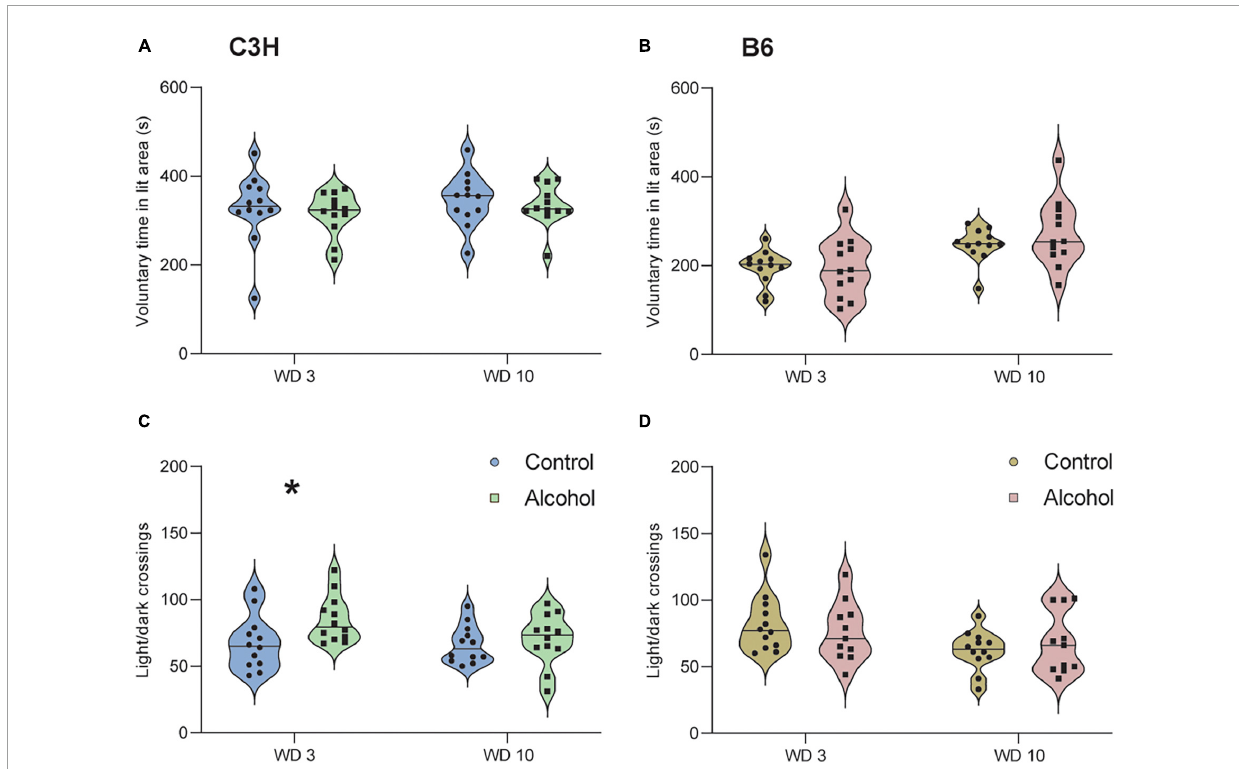
FIGURE5 No anxiogenic-like effects of alcohol exposure and subsequent withdrawal detected in the light/dark test. The % of time spent voluntarily in the lit area (A,B) and the number of light/dark crossing (C,D) were assessed in C3H and B6 mice at the 3rd and 10th day of alcohol withdrawal. Data are shown as individual subjects, horizontal line in violin plots represents group means. n = 12 per group/strain. * p < 0.05 represents One-way ANOVA followed by Benjamini–Hochberg’s post hoc , alcohol vs.